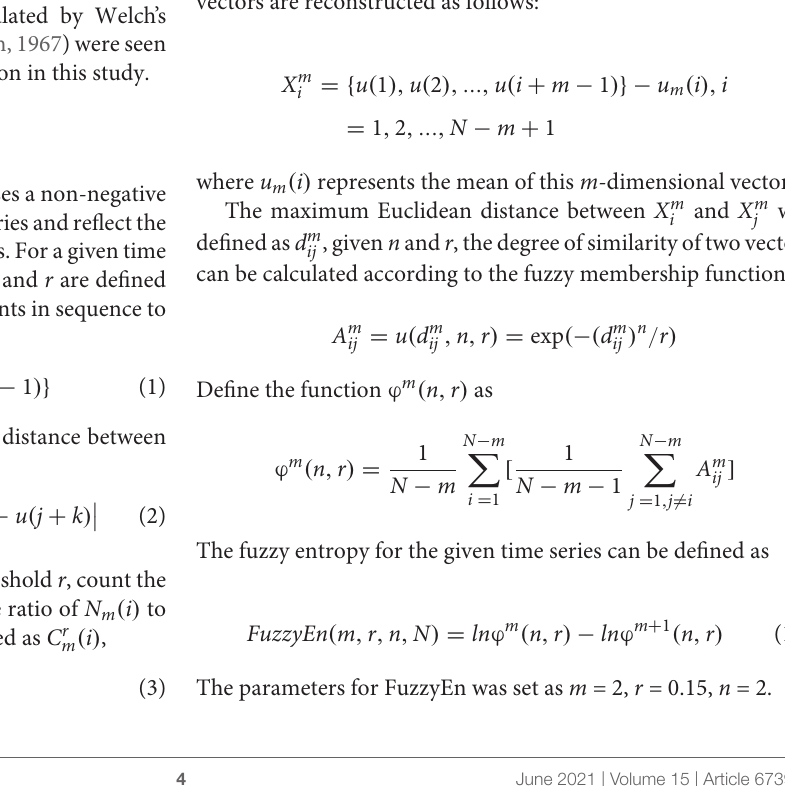
represent different attention levels in Results section.